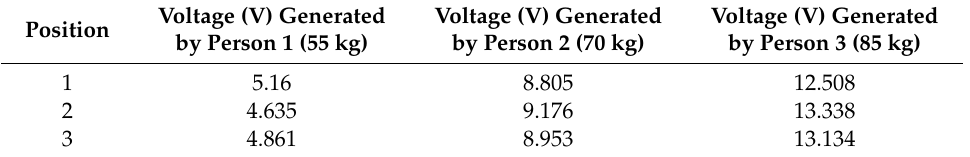
Table 4. Output voltage generated by the footfall of different persons with different positions. Voltage (V) Generated by Position